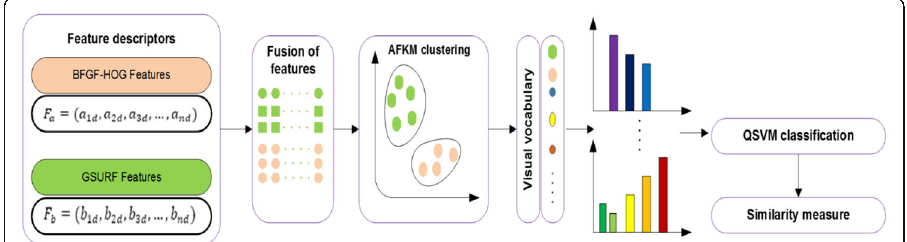
Fig. 4 Framework of the competitor method of non-adaptive complementary feature integration based on the BoVW